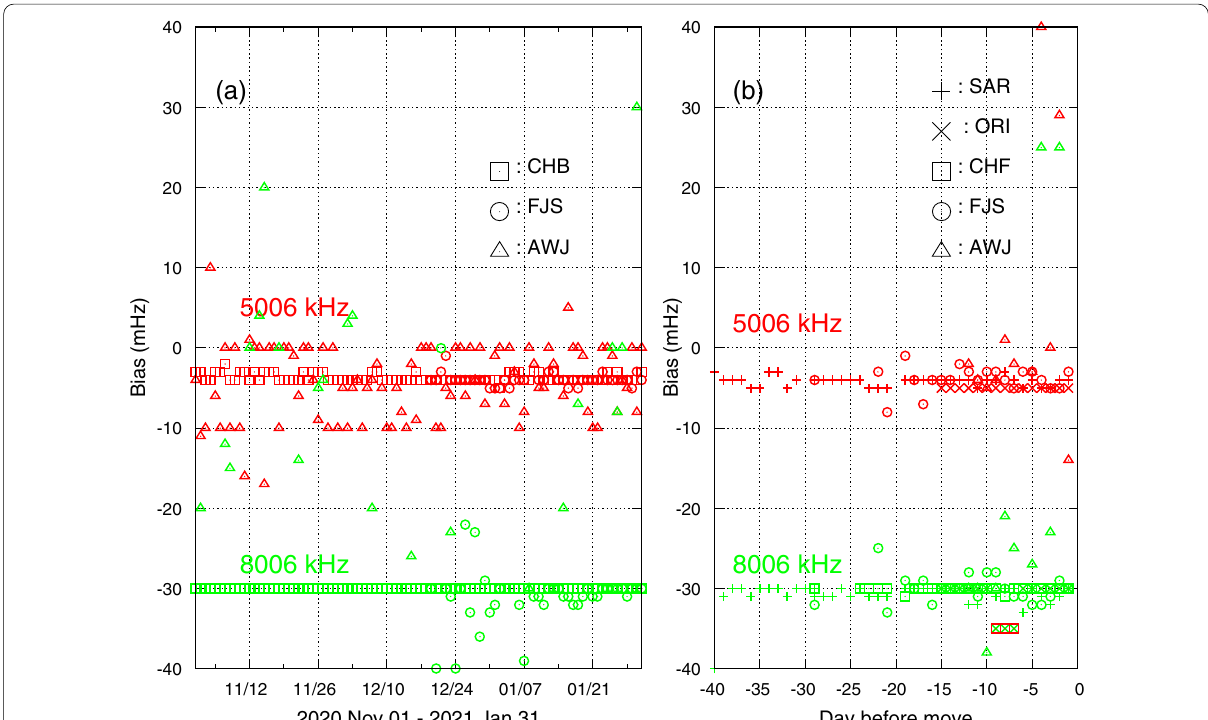
Fig. 13 Frequency bias in Doppler frequency. a Doppler frequency obtained at three digital receiving stations (CHB, FJS, and AWJ), which were sampled at 03 UT (12 JST) for two months from 01 November 2020 to 31 January 2021. b Doppler frequency obtained by the receivers under a receiving test in the laboratory for deployment to five stations (SAR, ORI, CHF, FJS, and